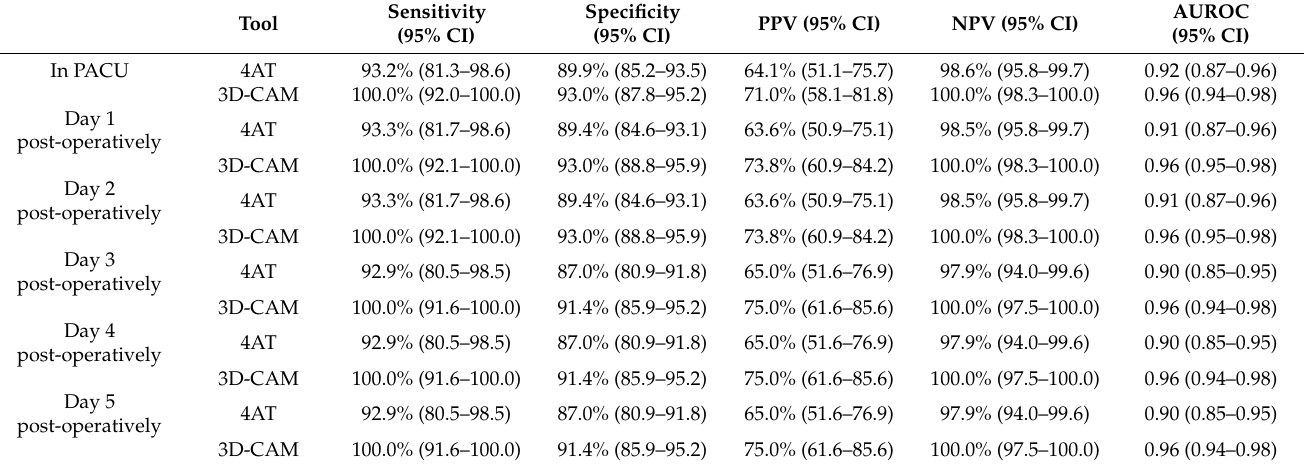
Table 2. Diagnostic test accuracy values of the 4AT and 3D-CAM in the study cohort of 271 patients. Patients with a definite delirium diagnosis ( n = 44) were classified as delirium positive compared with all other patients ( n =